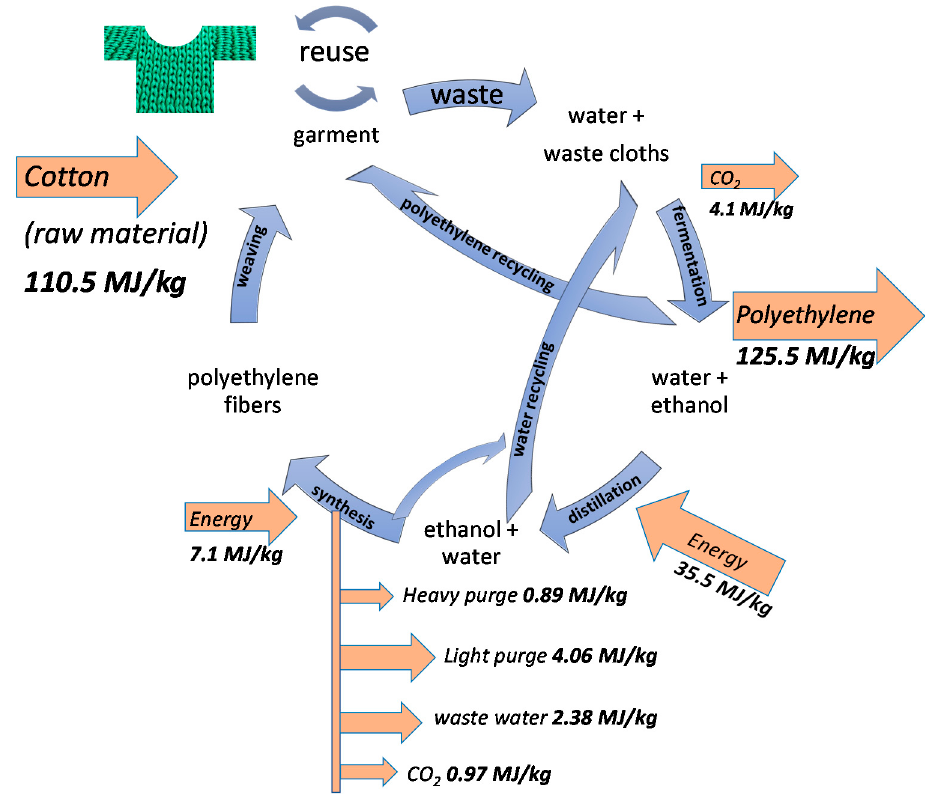
Figure 4. The circular economy process applied to cotton waste fermentation to 1 kg of polyethylene.